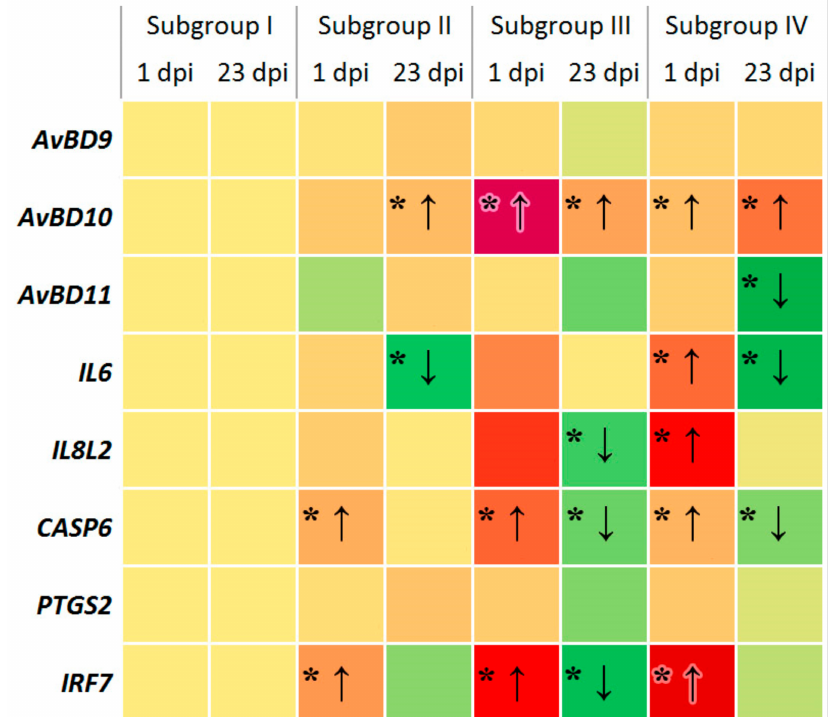
Figure 2. Heat map of expression of the chicken genes involved in the immune response due to SE infection and / or phytobiotic administration. * Red and green squares corresponded to significant gene up- ( ↑ ) and downregulation ( ↓ ) relative to Subgroup I ( p < 0.05). Yellow squares and other squares with no “*” meant respectively the basal expression level in Subgroup I (negative control) or no significant changes in the experiment